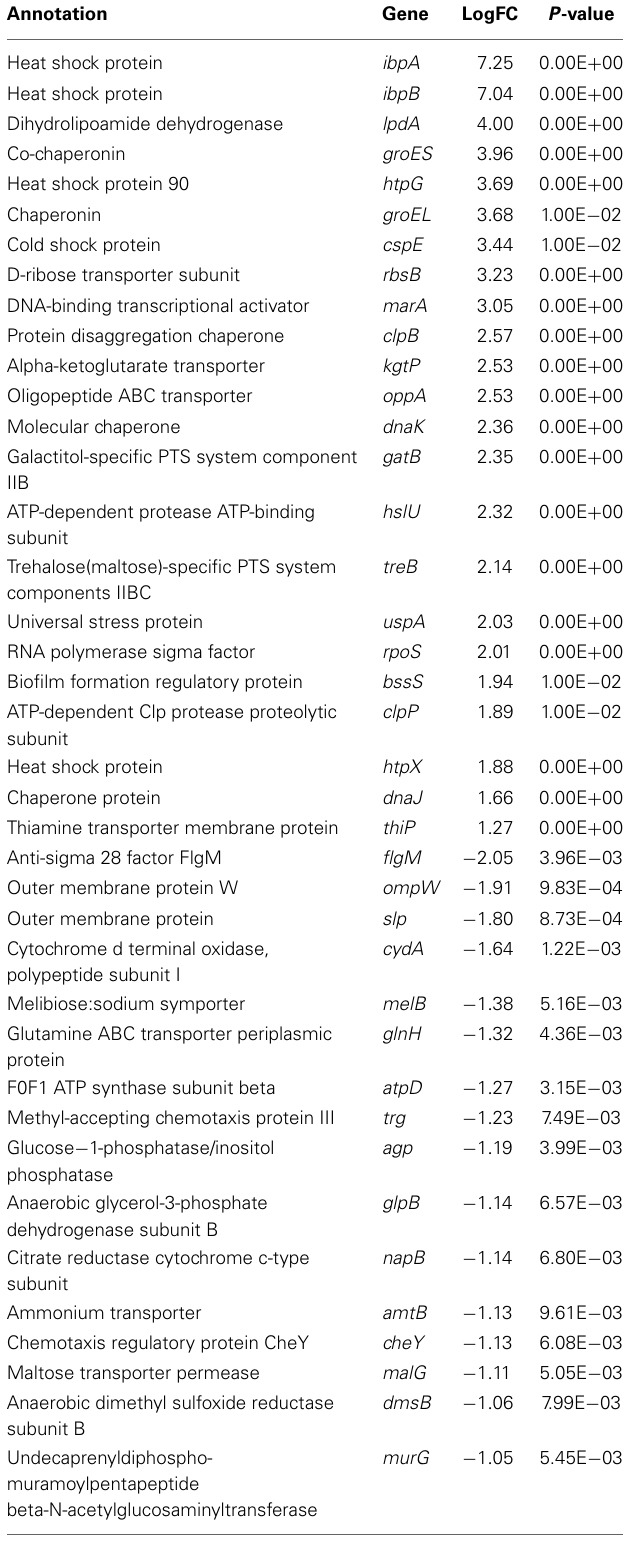
Table 2 | Genes with differential expression after the elevation of